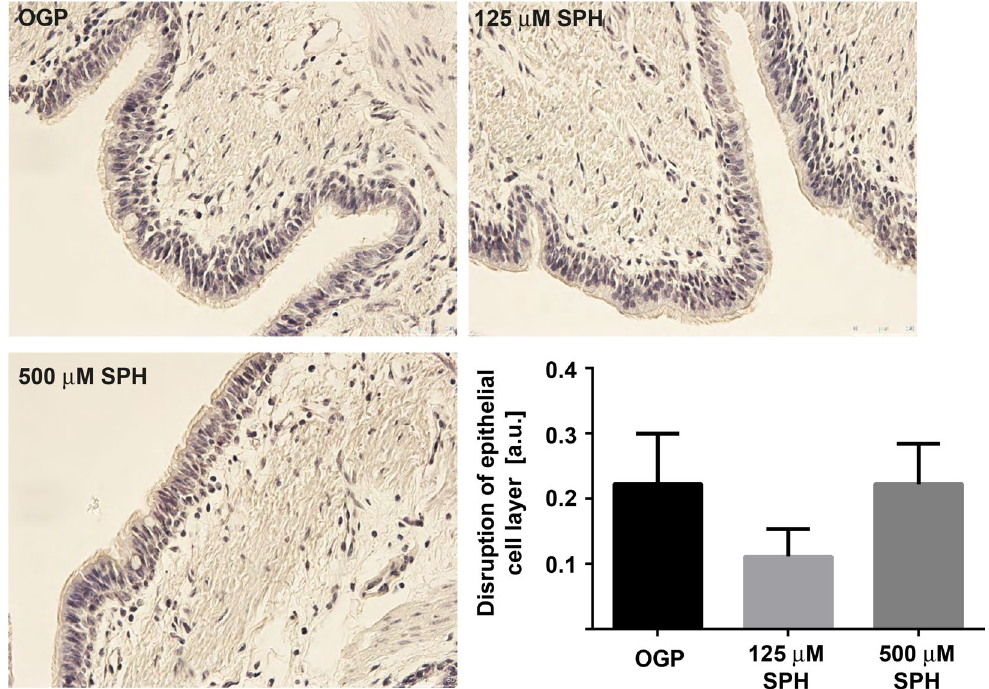
Figure 3. Sphingosine inhalation does not lead to disruption of epithelial layers. No loss of cell integrity after inhalation of sphingosine was observed. Paraffin sections from bronchial epithelial cell layers were stained with hemalaun. Out of each EVLP lung (125 µM sphingosine (n = 3), 500 µM sphingosine (n = 3) and OGP (n = 3) 3 sections with 5 visual fields were analyzed according to the following scoring system: No evidence of epithelial cell layer disruption and intact basal membrane, no leukocyte influx and less than 2% pyknotic, i.e. dead epithelial cells (Grade 0); Only small disruptions of the epithelial cell layer but basal membrane intact and no evidence of leukocyte influx with less than 5% pyknotic, i.e. dead epithelial cells (Grade 1); Larger disruptions of the epithelial cell layer are observed but basal membrane is still intact, no evidence of leukocyte influx and less than 10% pyknotic, i.e. dead epithelial cells were shown (Grade 2): Large disruptions of the epithelial cell layer, disruptions of basal membrane, leukocyte influx and more than 10% pyknotic, i.e. dead epithelial cells (Grade 3). Given are representative stainings and the mean ± SD from 3 sections with 5 visual fields per animal (blinded tests),